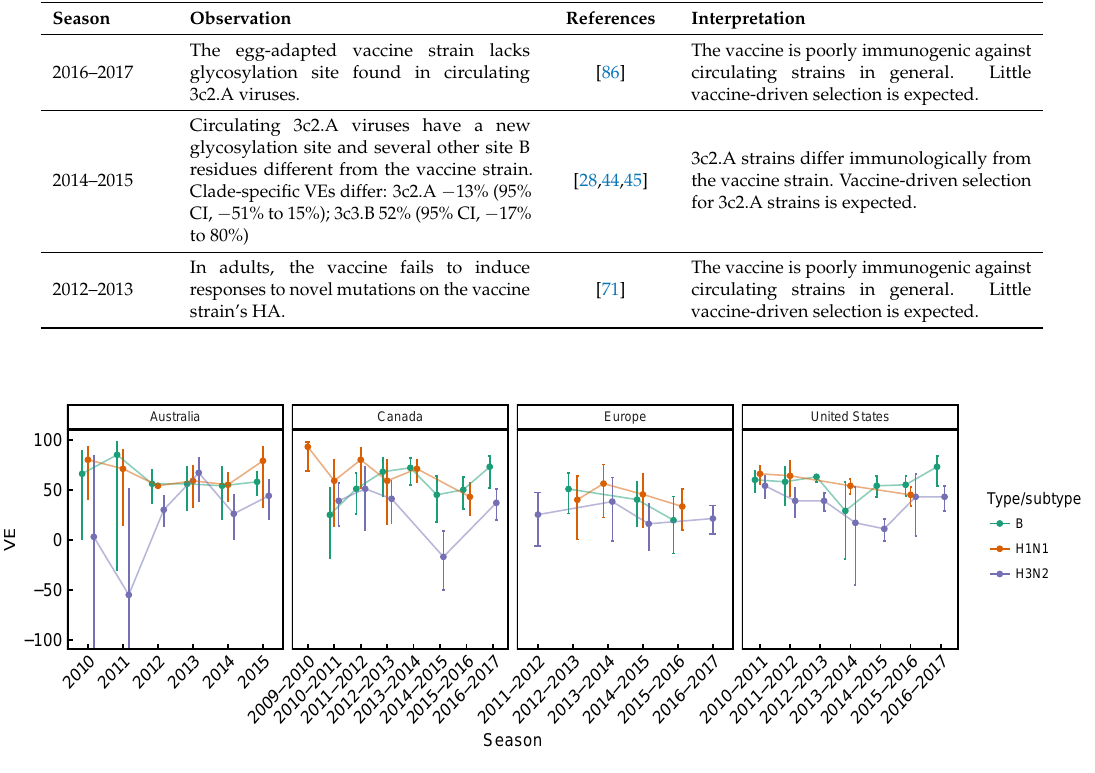
Figure A1. Seasonal vaccine effectiveness by type and subtype measured by test-negative design studies in Australia [24–26], Canada [27–34], Europe [35], and the United States [36–43] from the 2009–2010 season to the 2016–2017 season. European VEs include data from study sites in and Sweden. Error bars show 95% CIs. VE in the United States measures effectiveness against medically attended ARI caused by influenza. Elsewhere, VE measures effectiveness against medically attended ILI caused by influenza. European studies enroll individuals over nine years old, while other studies also enroll individuals from younger age groups.